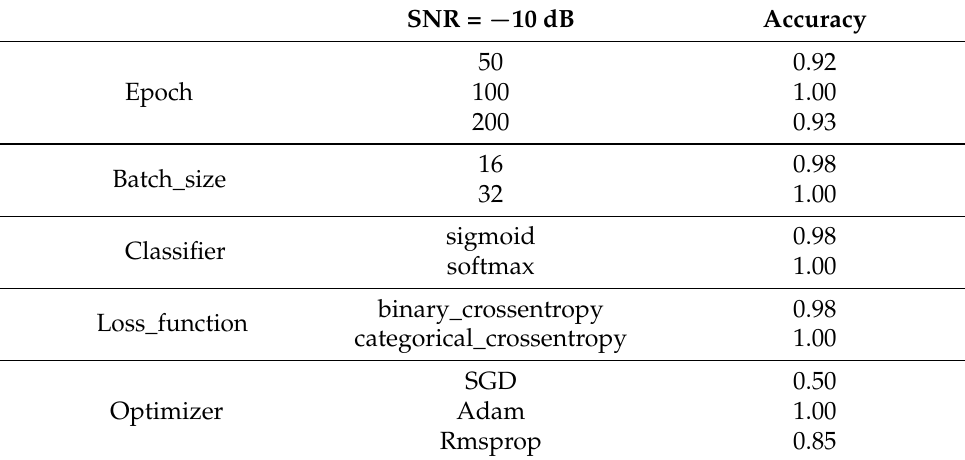
Table 1. The accuracy of CM-LSTM model parameters and related